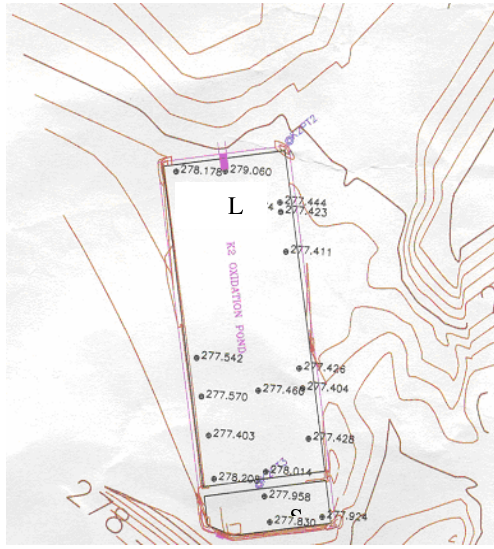
Figure 2: Existing layout of the K2